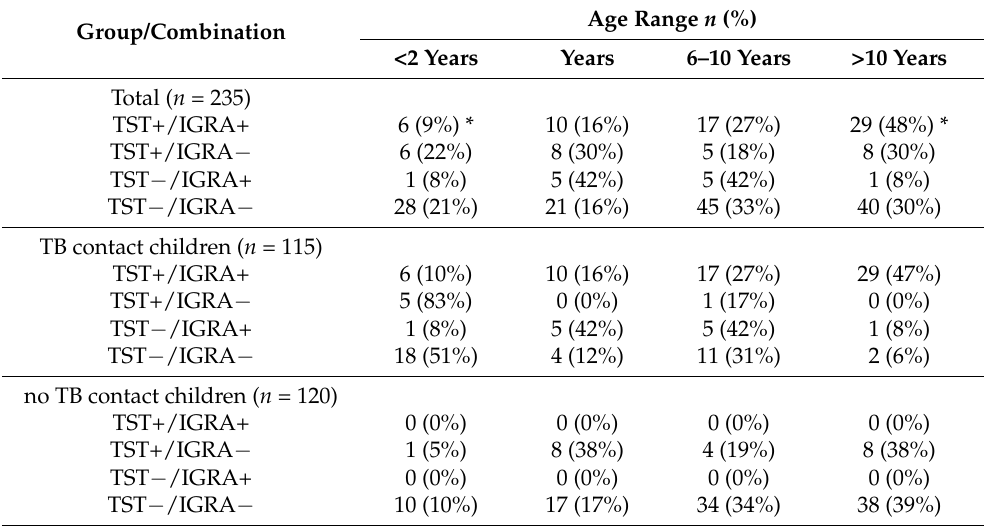
Table 6. Combination of the tuberculin skin test (TST) and interferon-gamma release assay (IGRA) results by age range.